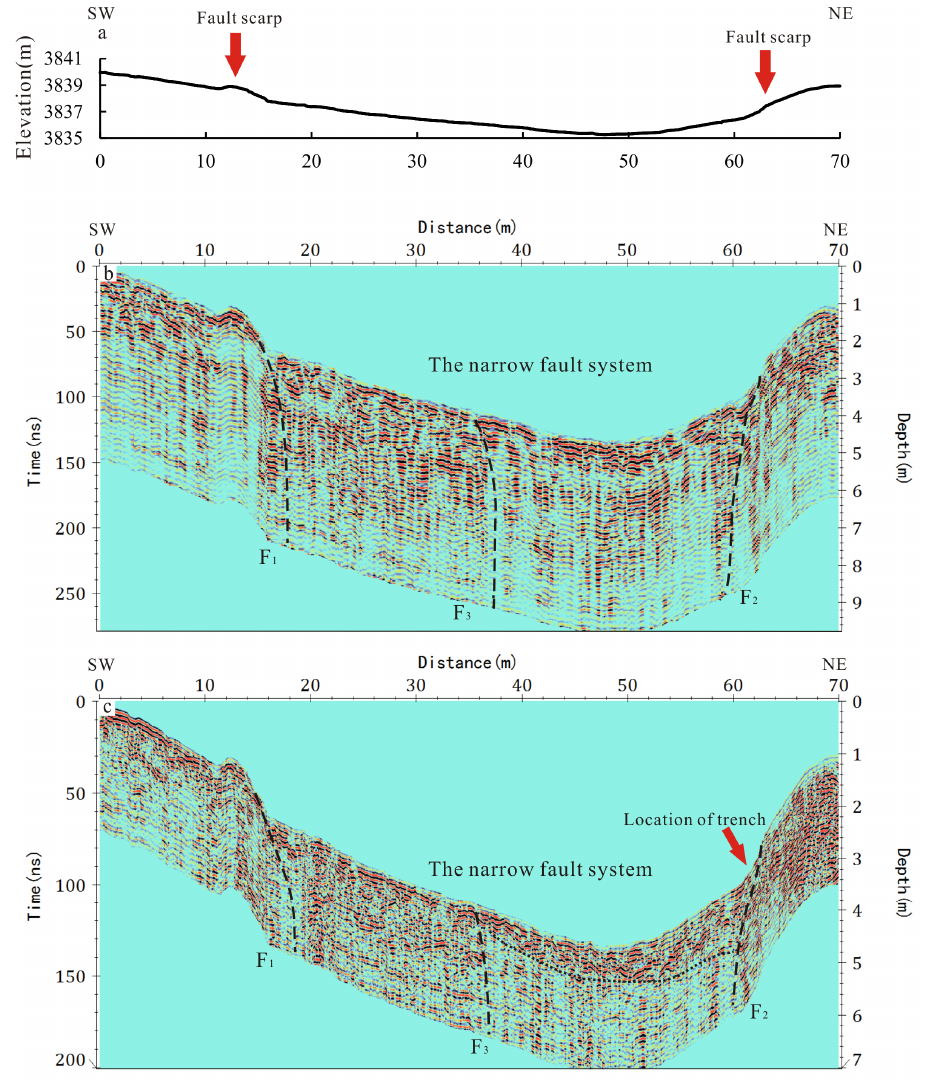
Figure 9. The interpreted 250 MHz and 500 MHz GPR data. ( a ) Topographic data of the 250 MHz and 500 MHz GPR measuring line (lines 3, 4 in the Figure 2b). ( b ) The interpreted 250 MHz GPR data. ( c ) The interpreted 500 MHz profile. Red arrows indicate the location of the trench wall (Figure 2b). Black dotted lines imply the interfaces of stratigraphic units.